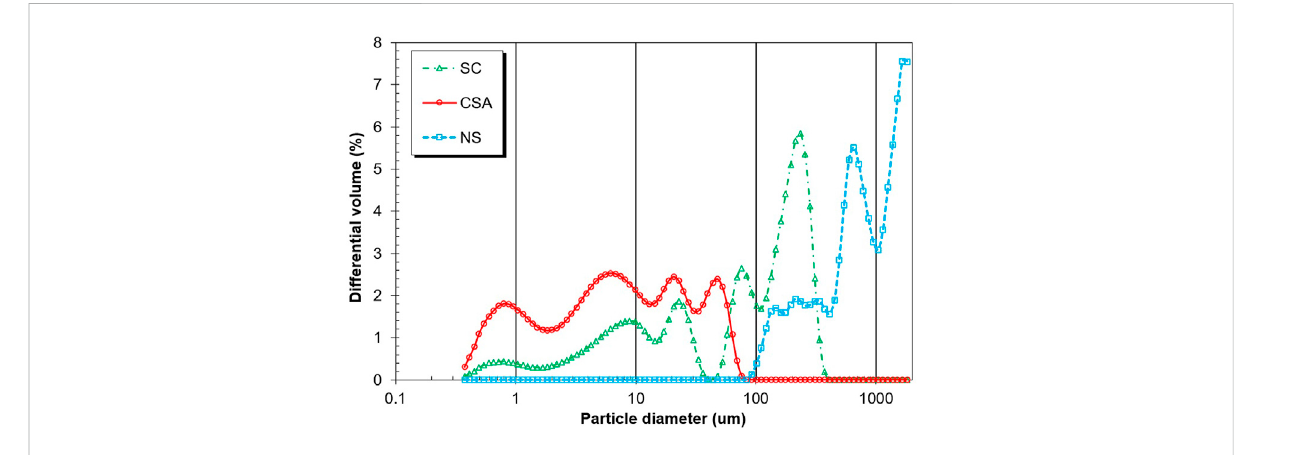
FIGURE 3 XRD diffractograms of raw and fl ash-calcined sediments.